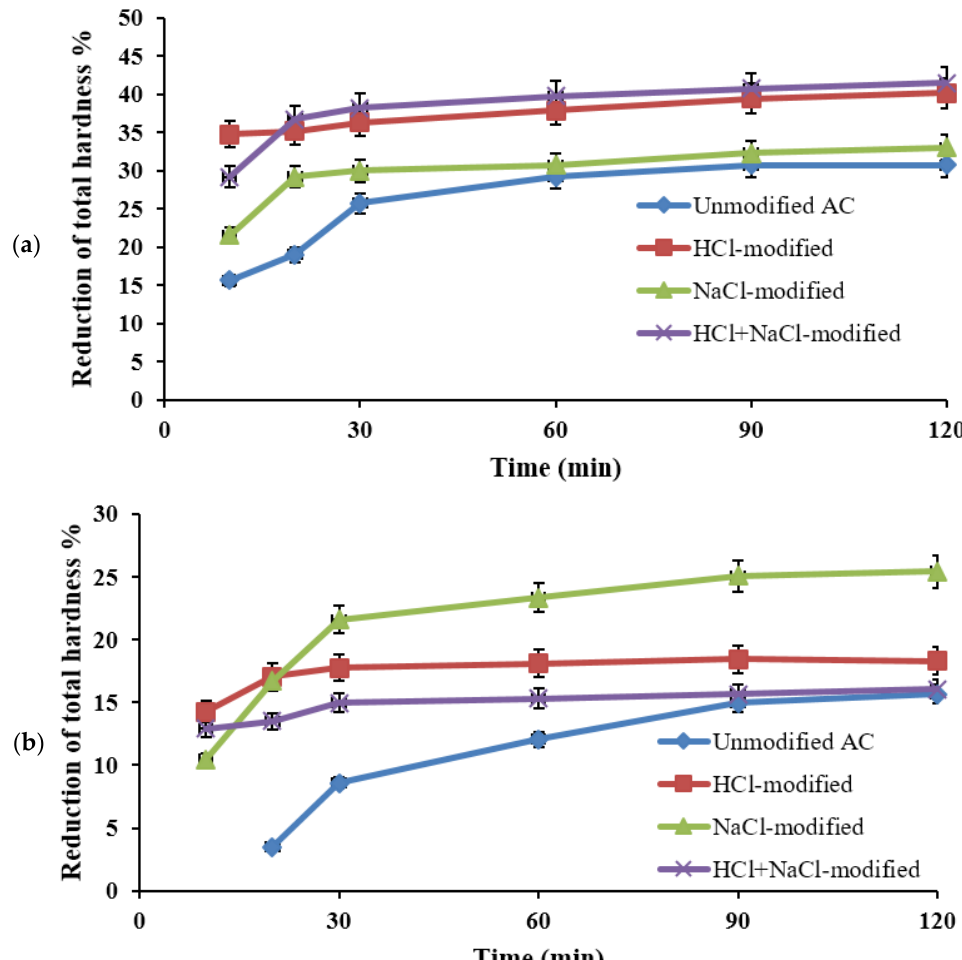
Figure 8. The effect of contact time on the decrease in total hardness (%) of ( a ) drinking water by modified activated carbon (AC) with a concentration of 60 g/L and ( b ) groundwater by modified activated carbon with a concentration of 40 g/L.